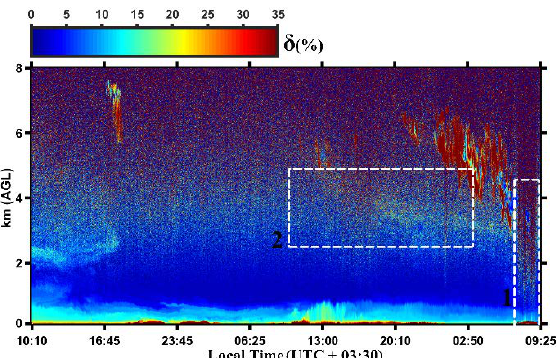
Figure 2 Time evolution of volume depolarization ratio between 06:40 UTC on 20 January 2019 and 06:00 UTC on 22 January